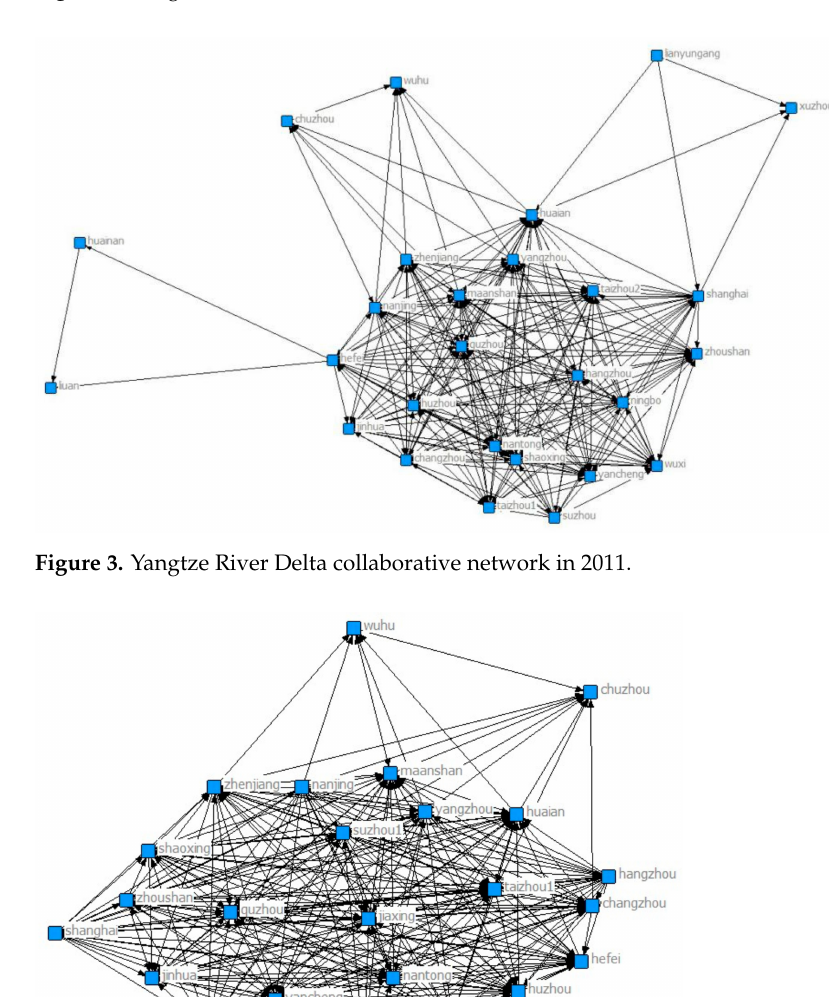
Figure 2. Yangtze River Delta collaborative network in 2010.